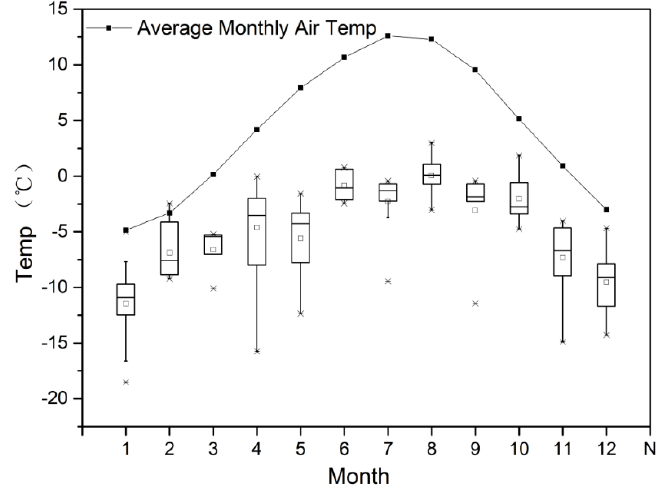
Figure 6. The average monthly surface temperatures of Hailuogou glacier from 1990 to 2018. Box charts are the average surface temperature of Hailuogou glacier, while the black line with dots is the average monthly air temperature at the Mt. Gongga station (3000 m a.s.l.).